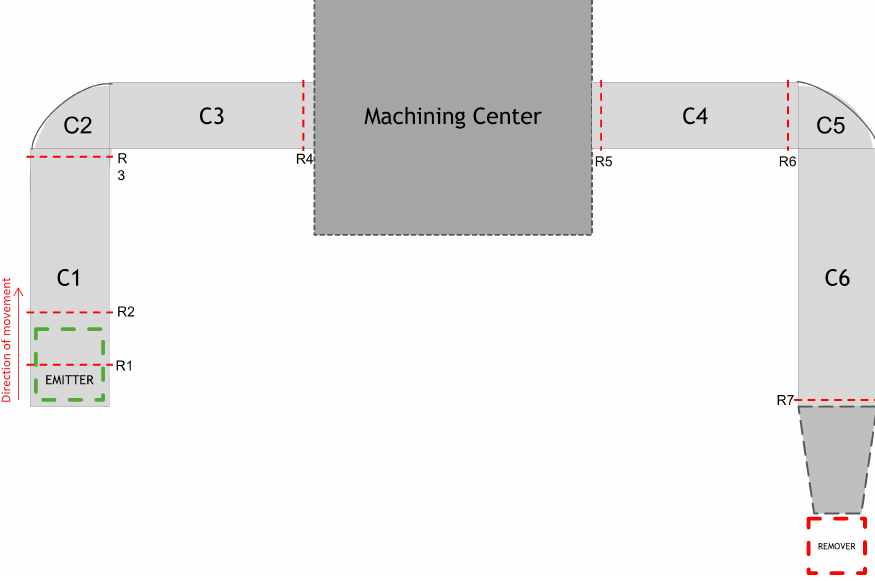
Figure 3. Scheme of production system.